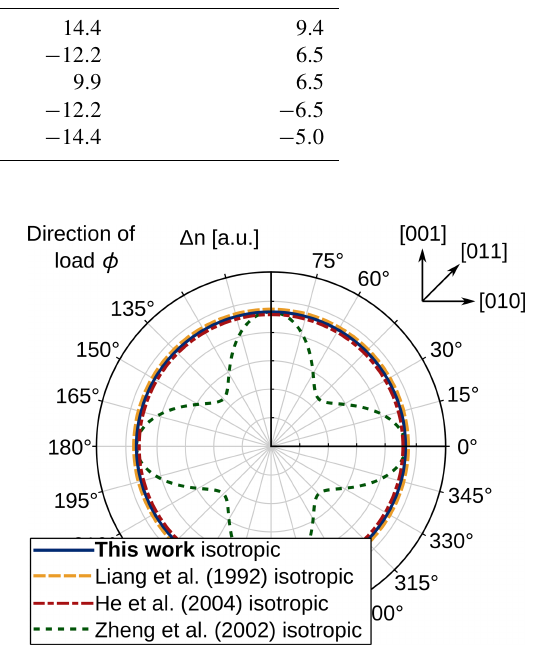
Figure 10. Comparison of the model derived in this study to models from the literature for the isotropic case of π 44 = ( π 11 − π 12